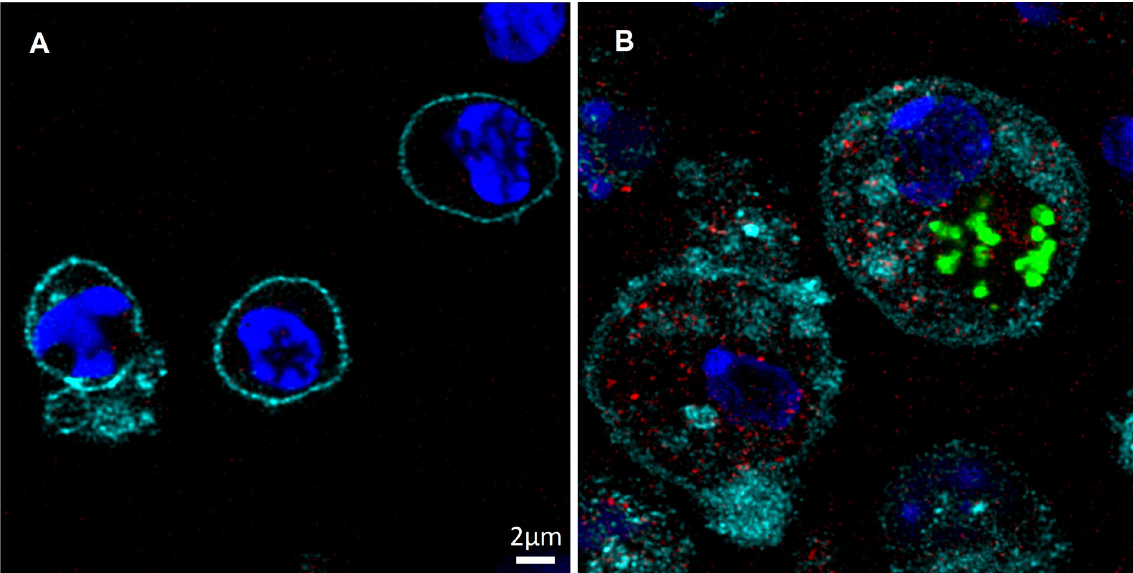
Fig 6. Ft LVS-infected DC produce IFN- γ . Rag1 KO mice were infected with 10 5 LVS i.d. Four days after infection, single cell suspensions of splenocytes from na ï ve (panel A) and GFP-LVS-infected Rag1 KO mice (panel B) were prepared and analyzed by confocal microscopy. IFN- γ - producing (red) CD11c + cells (cyan) were identified by cell surface staining coupled with ICS. GFP-LVS was identified as green, and all cells were counterstained with DAPI (blue) to identify nuclei. Images are representative of those evaluated in two independent experiments.